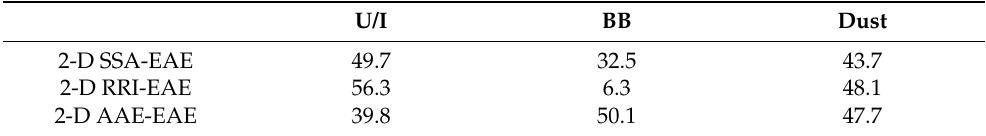
Figure 13. Scatterplots of aerosol samples with known types identified through the MD method in the form of 2 ‐ D classification using the parameters and thresholds (the boxes) similar as Figure 2: ( a ) SSA and EAE; ( b ) RRI and EAE; ( c ) AAE and EAE. Table 5. The percentages of the known aerosol types that could be also identified through the 2 ‐ D methods (unit: %).